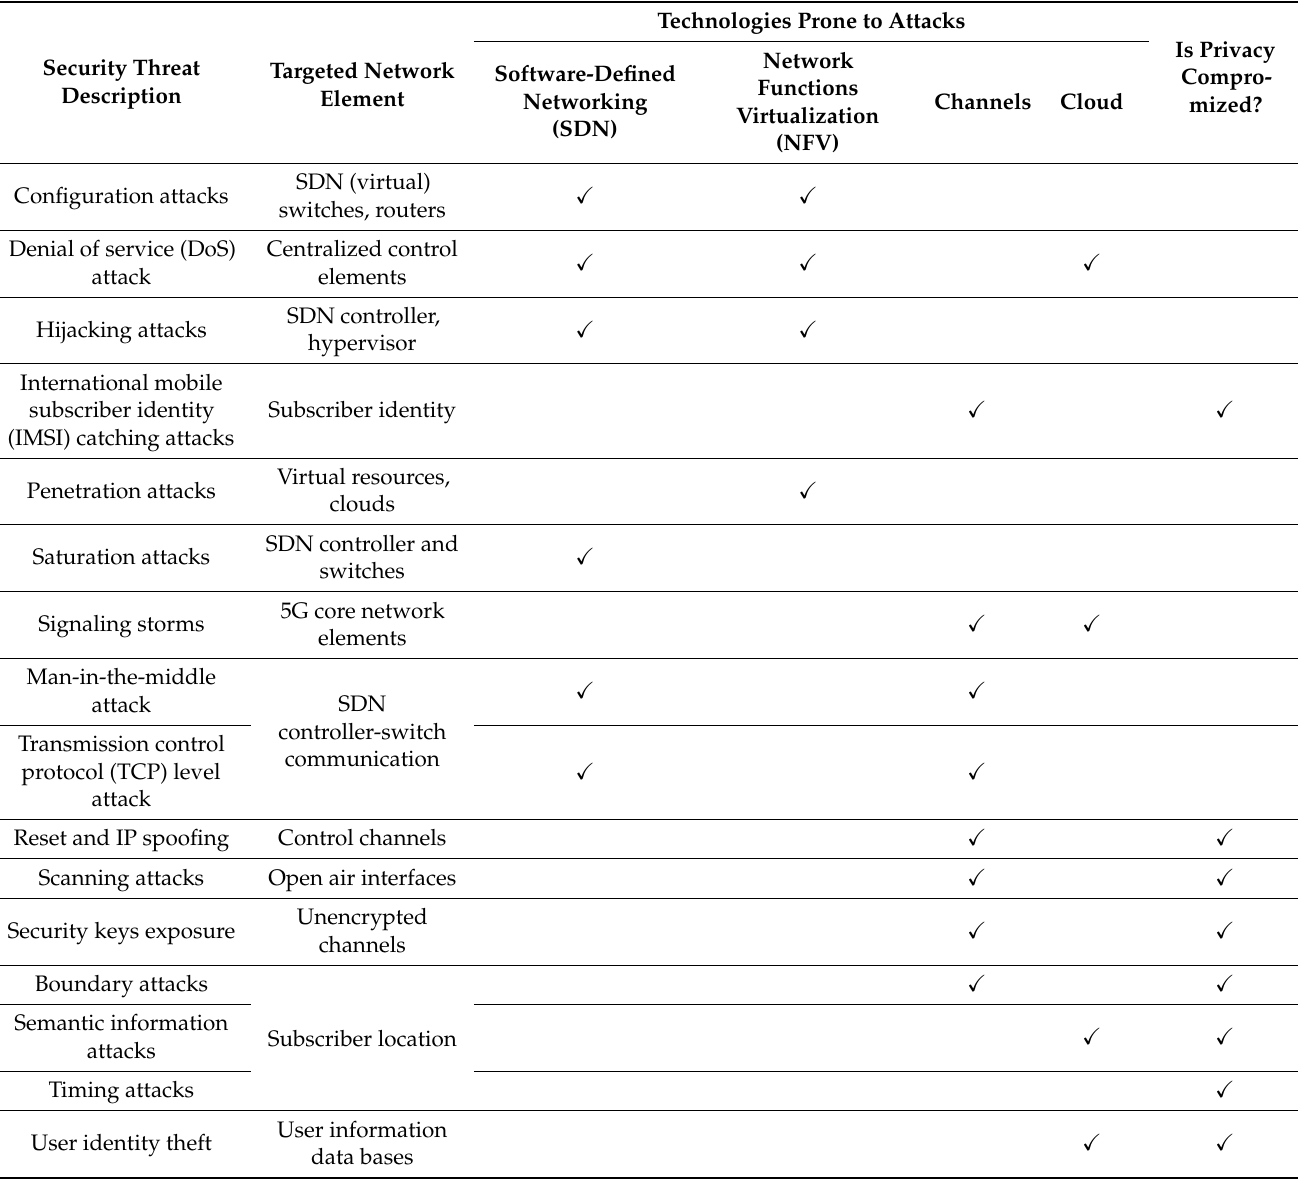
Table 7. Security challenges in 5G technologies (adopted from